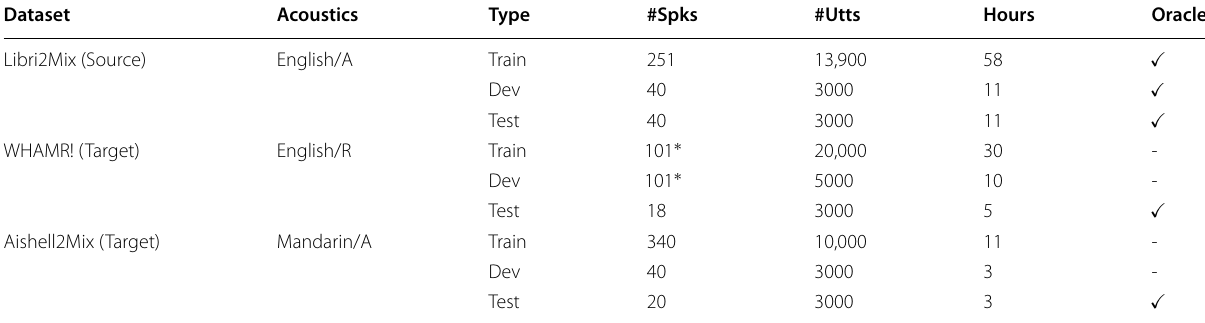
“A” and “R” refer to anechoic and reverberant, respectively. “Oracle” indicates whether the oracle (ground-truth) data is available. “ ∗ ′′ Means the speakers of different sets are same